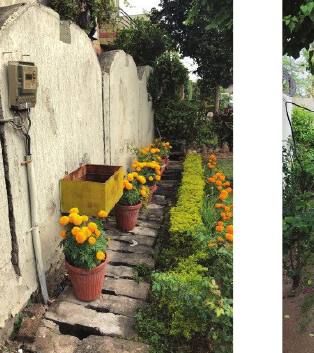
Figure 12. Balcony in